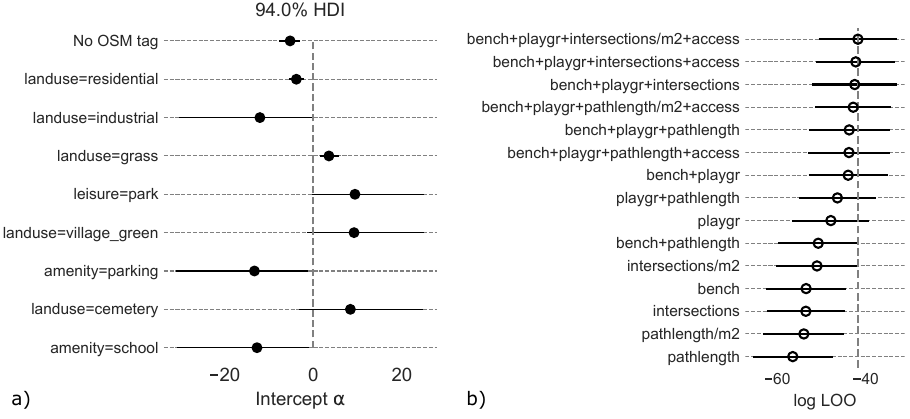
Figure 9. ( a ) Mean estimates for intercepts with 94% Bayesian credible intervals for different land use types and ( b ) Model comparison between several models with different additional contextual predictors based on the log ( LOO ) criterion; pathlength/m 2 = density of footpaths, intersections/m 2 = density of footpath intersections, playgr =